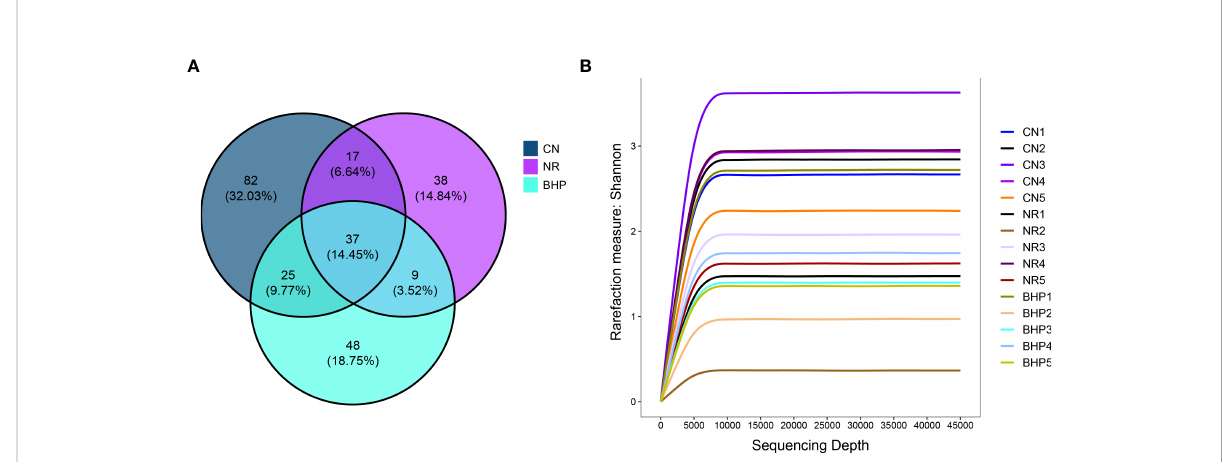
FIGURE 4 (A) Venn diagram of the number of OTUs distribution of lactase-producing bacteria from the intestinal contents in each group. Each circle represents a group, the overlapping area between the circles refers to the common OTUs between the groups, and the number of each area indicates the number of OTUs contained in the area. (B) Rarefaction curve of the lactase-producing bacteria from the intestinal contents in each group. The smoothness of the rarefaction curve re fl ected the effect of sequencing depth on the diversity of observed samples. The fl atter the curve, the more indicating that the sequencing results were suf fi cient to re fl ect the diversity contained in the current sample. CN, control group; NR, natural recovery group; BHP, Baohe pill decoction treatment